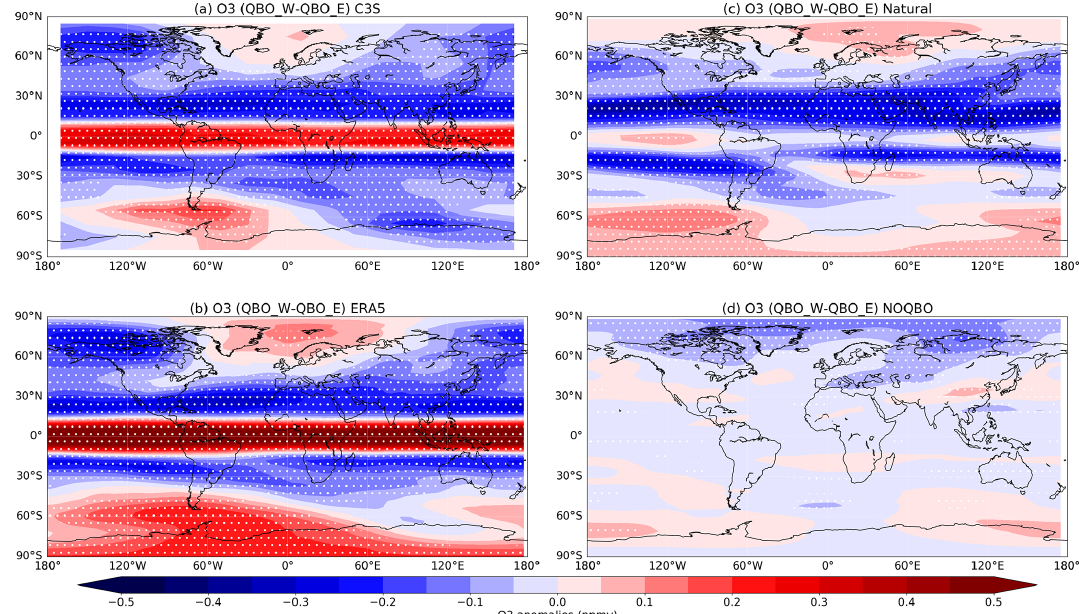
Figure 7. Influences of QBO (QBOW–QBOE) on global stratospheric ozone (10hPa) based on monthly anomalies from different data sets for the period 2002–2020. (a) Merged satellite data from C3S. (b) ERA5 data. (c) CESM-WACCM natural run. (d) CESM-WACCM NOQBO run. Stippled areas indicate results that are statistically significant over the 95% level, using the two-tailed Student’s t test.